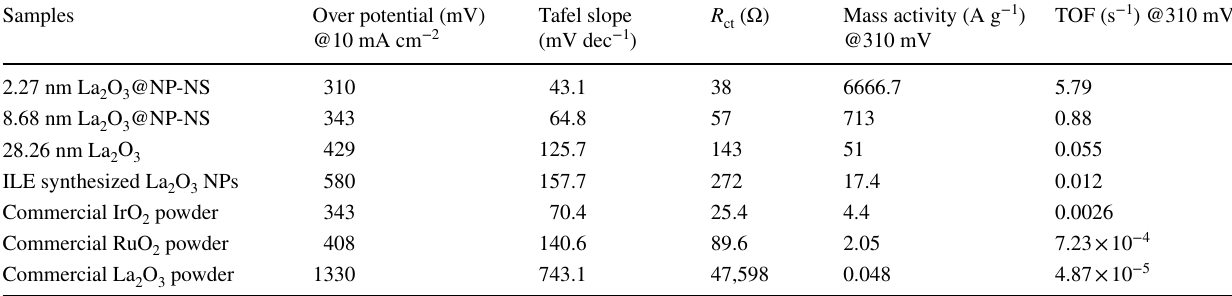
Table 1 OER performance comparison between the samples synthesized in this work Samples